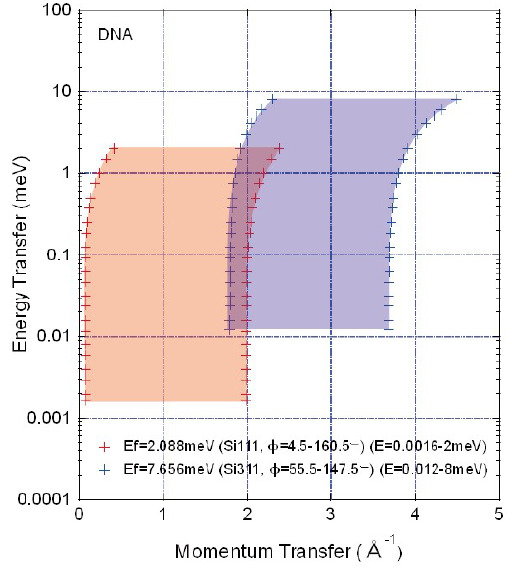
Fig. 4. The wide Q-E region measurable by DNA. The areas for Si111 and Si311 are hatched by orange and